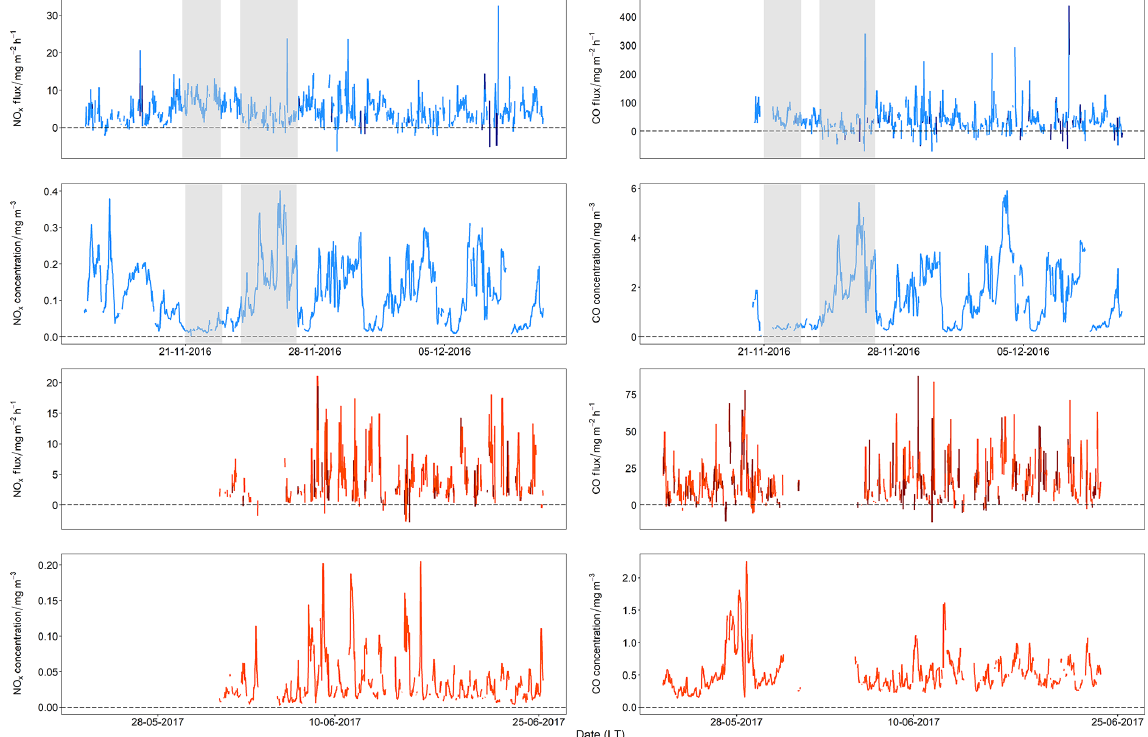
Figure 4. Time series data for 30min averaged NO x and CO fluxes for the winter (blue trace) and summer (orange trace) campaigns with fluxes outside of the 60% stationarity criteria shown in darker colours. Gaps in the time series are due to instrument problems. The two contrasting periods discussed in Sect. 3.2 are highlighted in